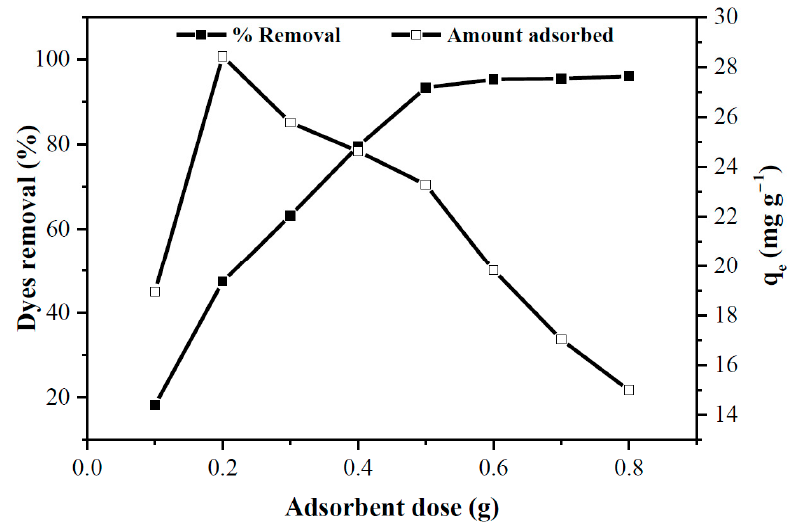
Figure 5 Figure 5. Effects of adsorbent dosage on the dye adsorption onto the banana peel (pH = 7, C i : 50 mg/L, M ads : 0.1 to 0.8 g, t : 1 h, T: 25 ◦ C, S: 180 rpm, solution volume: 250